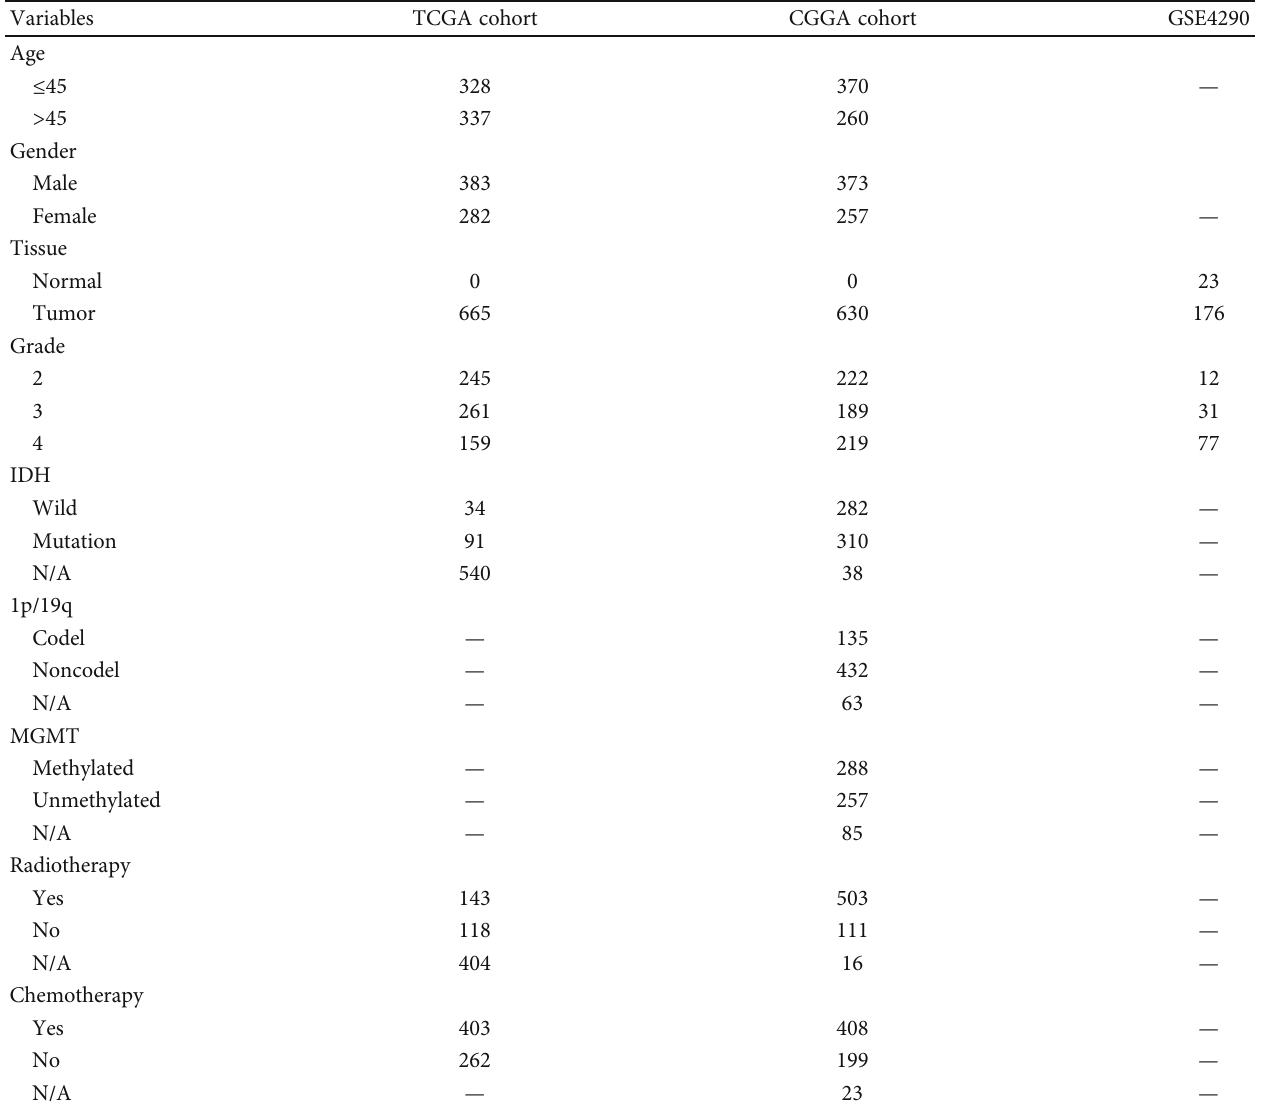
Table 1: Clinicopathological characteristics of glioma patients included in this